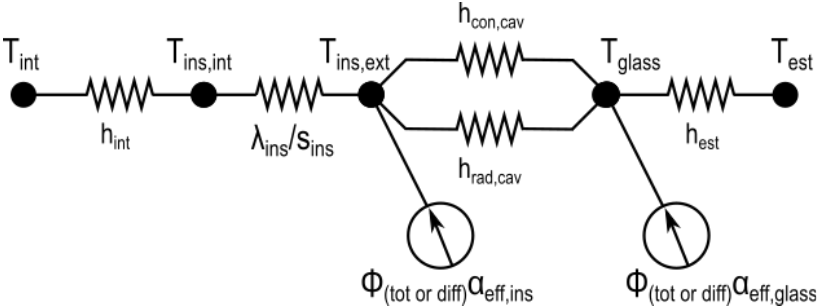
Figure 5. Thermal network generated from the local analysis of the spandrel system shown in Figure 1.